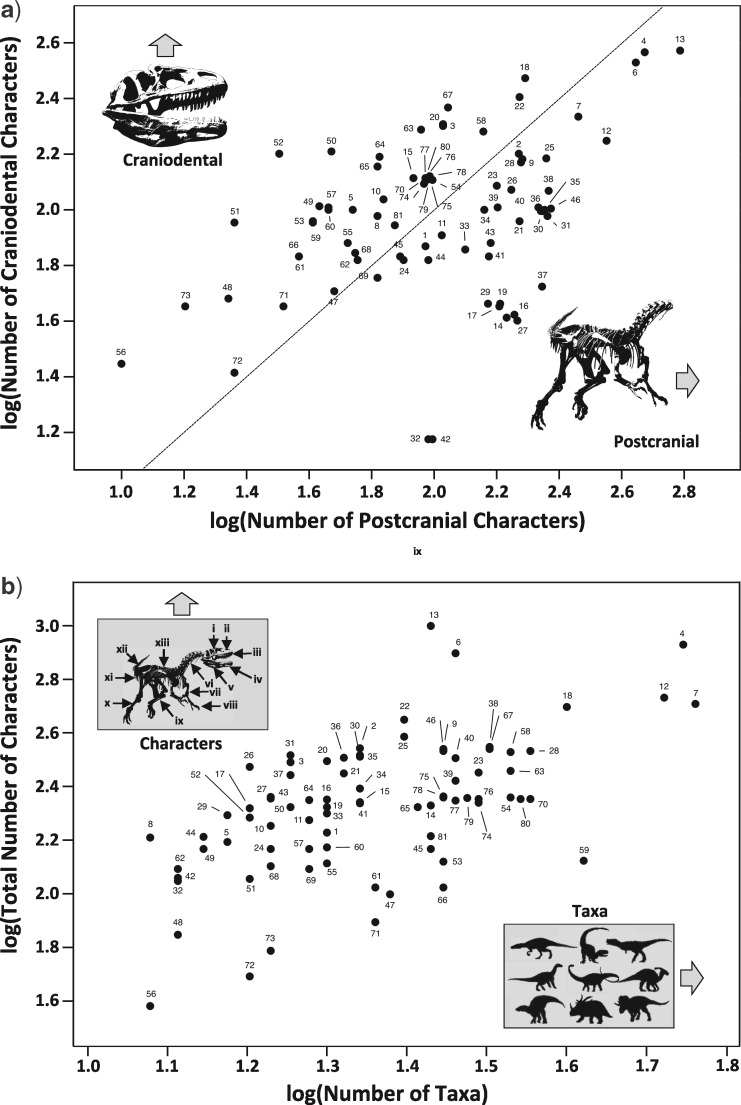
Scatter plots of data matrix and data matrix partition dimensions across our 81 analyzed matrices of non-avian Dinosauria. a) log(number of craniodental characters) against log(number of postcranial characters). The dotted line indicates the 1:1 slope. Points above this line have a higher proportion of craniodental characters, while points below have a higher proportion of postcranial characters. Numbers of craniodental and postcranial characters are not significantly different according to a paired Wilcoxon test (\documentclass[12pt]{minimal}
\usepackage{amsmath}
\usepackage{wasysym} 
\usepackage{amsfonts} 
\usepackage{amssymb} 
\usepackage{amsbsy}
\usepackage{upgreek}
\usepackage{mathrsfs}
\setlength{\oddsidemargin}{-69pt}
\begin{document}
}{}$P=$\end{document} 0.1343). b) log(total number of characters) against log(total number of taxa). Source papers are as follows: Theropoda 1. Allain et al. (2012), 2. Araújo et al. (2013), 3. Brusatte and Benson (2013), 4. Brusatte et al. (2014), 5. Canale et al. (2015), 6. Cau et al. (2012), 7. Choiniere et al. (2014), 8. Eddy and Clarke (2011), 9. Evers et al. (2015), 10. Fanti et al. (2012), 11. Farke and Sertich (2013), 12. Foth et al. (2014), 13. Godefroit et al. (2013), 14. Hu et al. (2015), 15. Lamanna et al. (2014), 16. Lee et al. (2014), 17. Li et al. (2014), 18. Loewen et al. (2013), 19. Longrich et al. (2011), 20. Lu et al. (2014), 21. Novas et al. (2013), 22. Parsons and Parsons (2015), 23. Porfiri et al. (2014), 24. Sanchez-Hernandez and Benton (2014), 25. Senter et al. (2012), 26. Tortosa et al. (2014), 27. Wang et al. (2015), 28. Zanno and Makovicky (2013), 29. Zhou et al. (2014), Sauropodomorpha 30. Carballido and Sander (2014), 31. Carballido et al. (2015), 32. D’Emic (2013), 33. Fanti et al. (2015), 34. Gorscak et al. (2014), 35. Lacovara et al. (2014), 36. Li et al. (2014), 37. Mannion et al. (2013), 38. McPhee et al. (2015), 39. Pol et al. (2011a), 40. Rauhut et al. (2015), 41. Rubilar-Rogers et al. (2012), 42. Saegusa and Ikeda (2014), 43. Santucci and De Arruda-Campos (2011), 44. Tschopp and Mateus (2013), 45. Wilson and Allain (2015), 46. Xing et al. (2015), Cerapoda 47. Evans and Ryan (2015), 48. Farke et al. (2011), 49. Farke et al. (2014), 50. Han et al. (2015), 51. Longrich (2011), 52. Longrich (2014), Ornithopoda 53. Boyd and Pagnac (2015), 54. Boyd (2015), 55. Brown et al. (2011), 56. Evans et al. (2013), 57. Godefroit et al. (2012), 58. He et al. (2015), 59. McDonald (2012), 60. McGarrity et al. (2013), 61. Norman (2015), 62. Norman et al. (2011), 63. Prieto-Marquez and Wagner (2013), 64. Prieto-Marquez (2014), 65. Prieto-Marquez et al. (2013), 66. Shibata et al. (2015), 67. Xing et al. (2014), Thyreophora 68. Arbour and Currie (2013), 69. Arbour et al. (2014), 70. Barrett et al. (2014), 71. Burns and Currie (2014a), 72. Burns and Currie (2014b), 73. Burns et al. (2011), 74. Butler et al. (2011), 75. Coria et al. (2013), 76. Godefroit et al. (2014), 77. Han et al. (2012), 78. Osi et al. (2012), 79. Pol et al. (2011b), 80. Ruiz-Omenaca et al. (2012), 81. Thompson et al. (2012). Allosaurus images in panels a and b modified from: https://commons.wikimedia.org/wiki/File:Allosaurus_AMNH_lobby_(white_background).jpg. Other dinosaur silhouettes drawn by Yimeng Li.